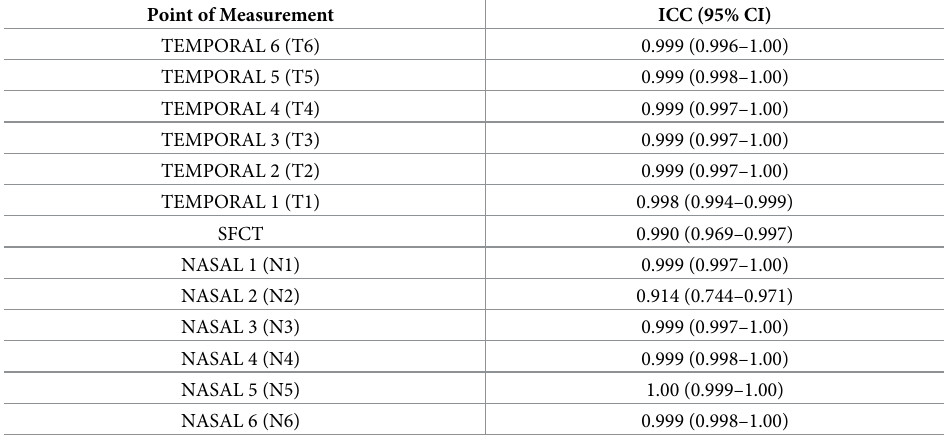
Table 4. Repeatability measures of choroidal thickness at different point locations.